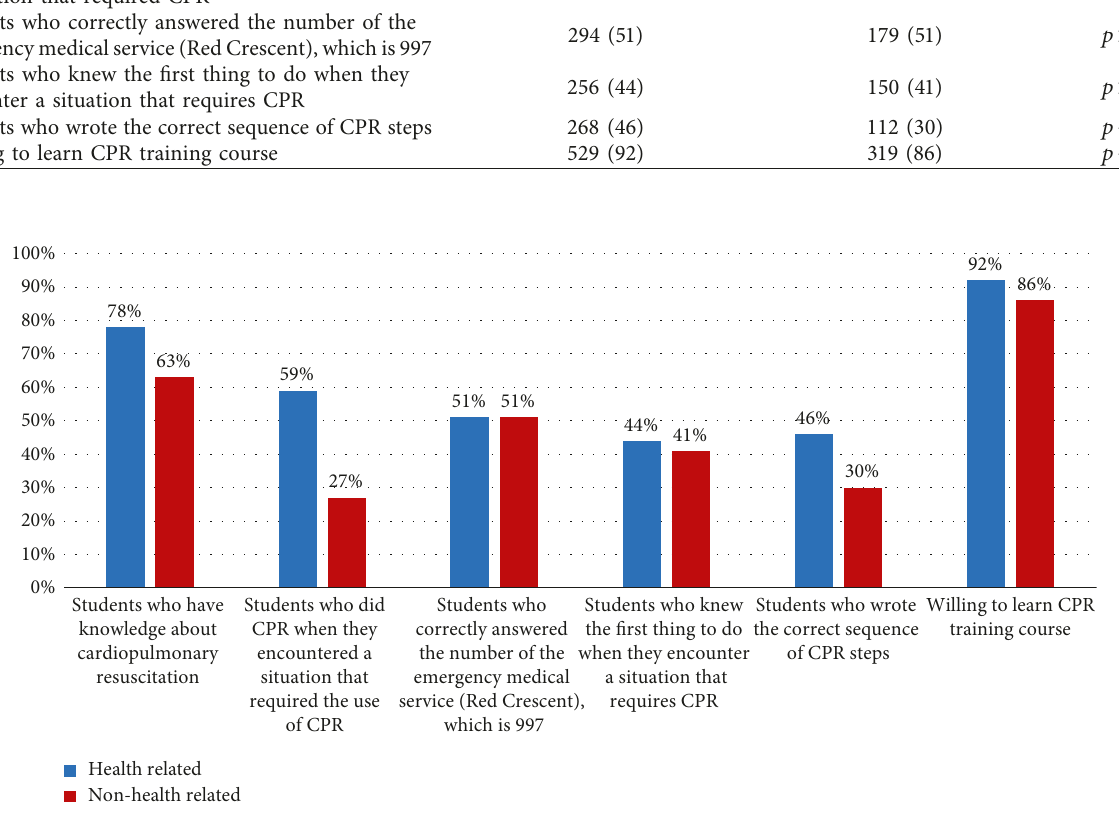
Figure 7: Comparison between health-related colleges and non-health-related colleges.